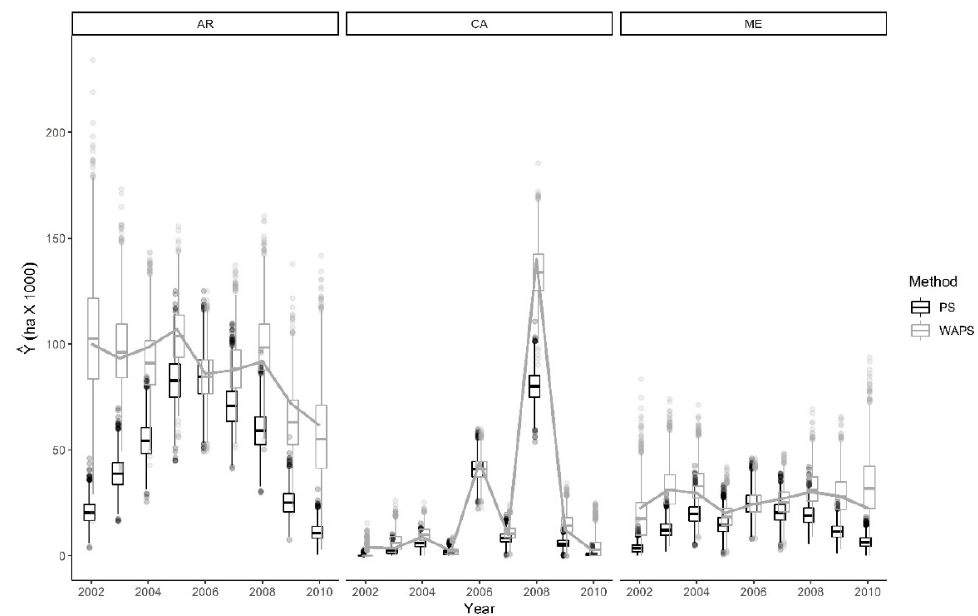
Figure 2. Distribution of the estimated total ( ˆ Y ) for the post-stratified (PS) method (black box and whisker plot) and for the weight adjusted post-stratified (WAPS) method (gray box and whisker plots) for each disturbance year and population. The solid grey line is the true population total ( Y ).